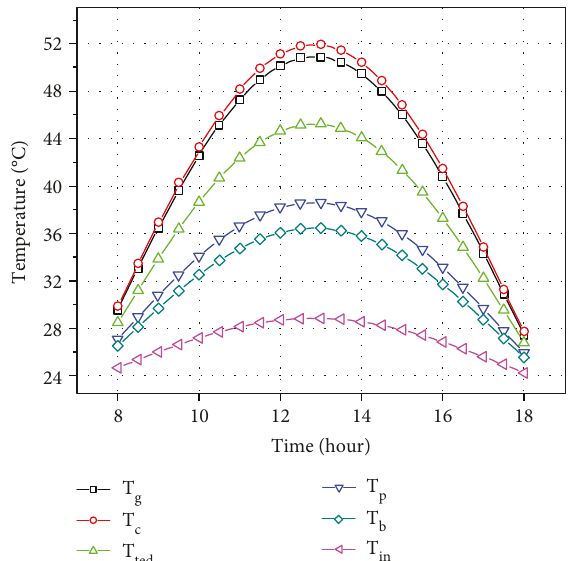
Figure 3: Hourly variation of the PV/T air collector element temperature.